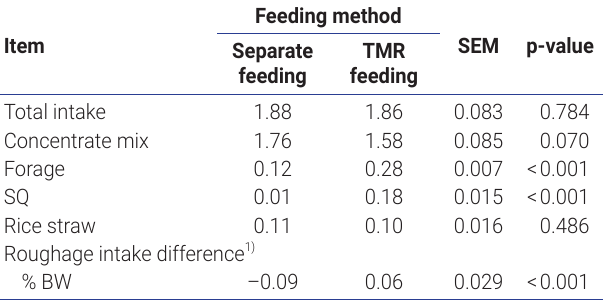
Table 8. Daily feed intake of animals by feeding method (% BW, dry matter basis)